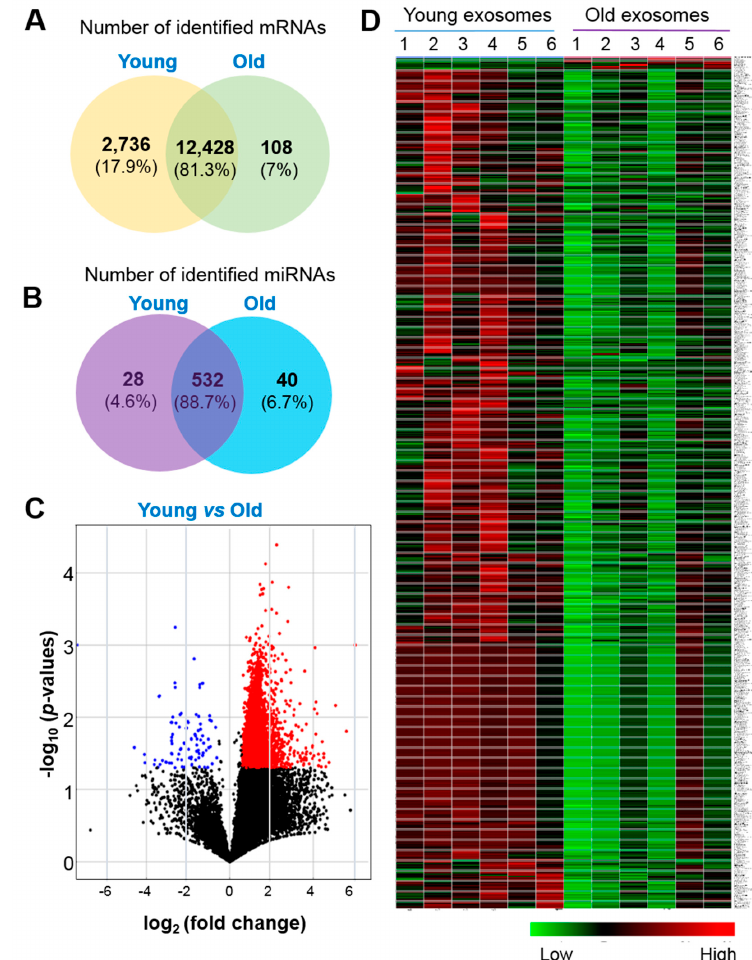
Figure 2. Profiles for mRNAs and miRNAs of serum exosomes from young and old rats. ( A-B ) Venn diagram of all di ff erentially expressed mRNAs ( A ) and miRNAs ( B ) identified in serum exosomes. ( C ) Volcano plot for comparing the differentially expressed exosomal mRNAs and miRNAs in serum from young and old rats after analysis with TargetScan (fold change > 1.5 and p < 0.05). ( D ) Heatmap of the differentially expressed mRNAs and miRNAs in serum exosomes from young and old rats ( n = 6 each group) after TargetScan (fold change > 1.5 and p < 0.05). Young, serum exosomes from young rats; Old, serum exosomes from old rats.